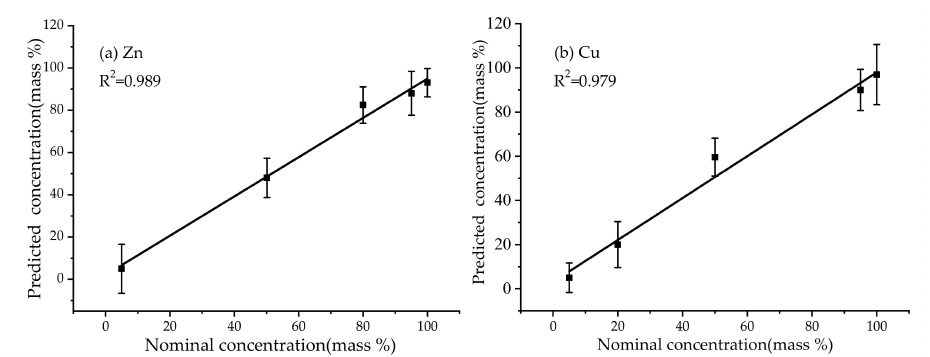
Figure 6. The correlation relationship between predicted concentration and nominal concentration of Zn ( a ) and Cu ( b ) based on multiple linear